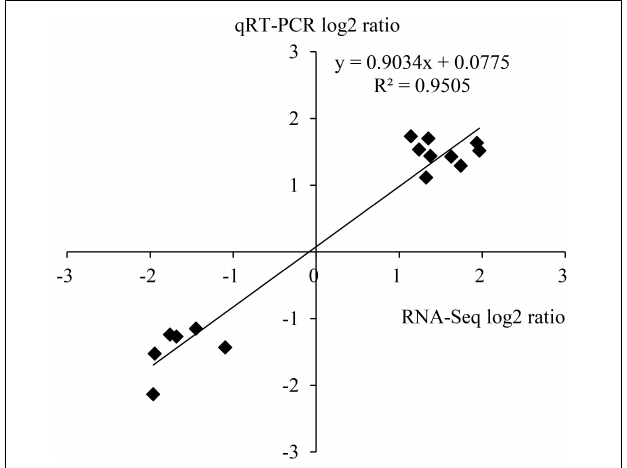
FIGURE 9 | Correlation between RNA-seq and